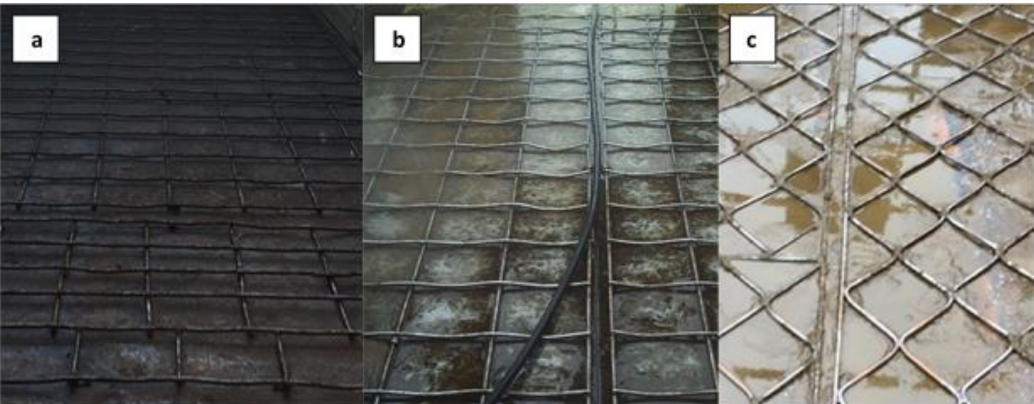
Figure 3. Di ff erent types of wire mesh that were used for the 23 observed slaughter horse transports. ( a ) Standard wire mesh—here addressed as “standard”; ( b ) standard wire mesh, which is curved between connection points—here called “curved”; ( c ) diamond shaped wire mesh, with connections in one plane—here called “diamond shaped”.